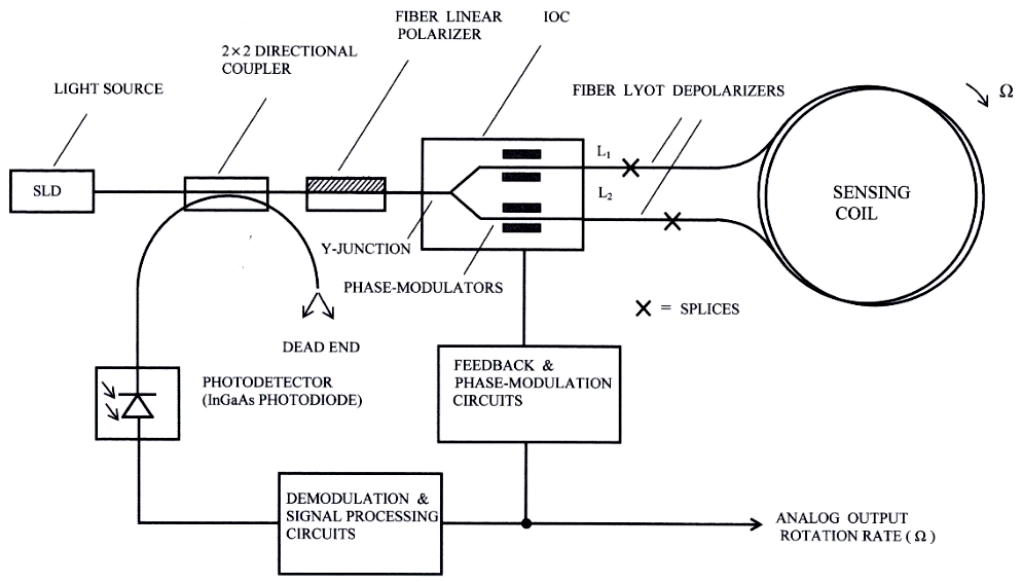
Figure 1. Electro-optical system configuration.